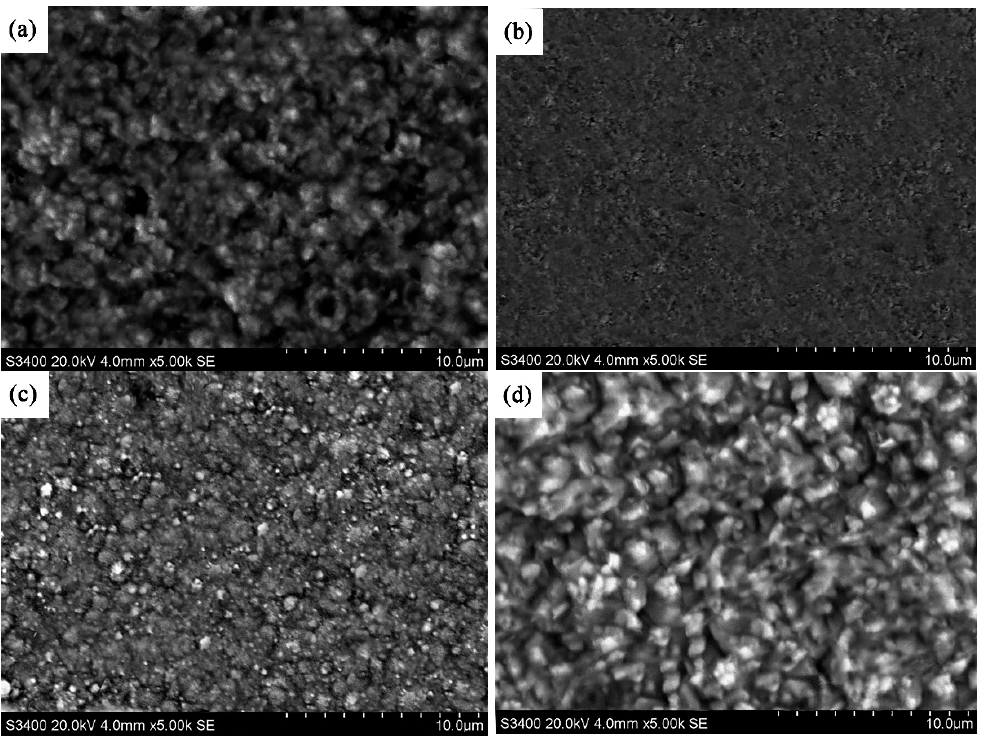
Figure 3. Effect of the SiC content in the electroplate liquid on the surface morphology of Ni/W-SiC nanocomposites: ( a ) 4 g/L, ( b ) 7 g/L, ( c ) 10 g/L, and ( d ) 13 g/L.